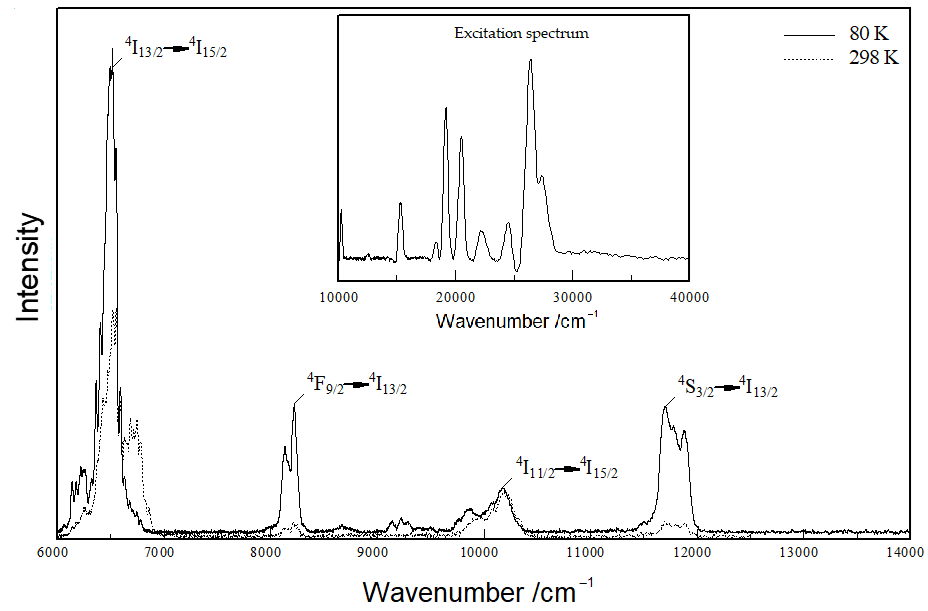
Figure 9. Emission spectrum of Y 3 F[Si 3 O 10 ]:Er 3+ excited at 375 nm at room temperature ( dotted curve ) and 80 K ( solid curve ); excitation spectrum inserted of Y 3 F[Si 3 O 10 ]:Er 3+ detected at the emission energy of 536 nm at room temperature.